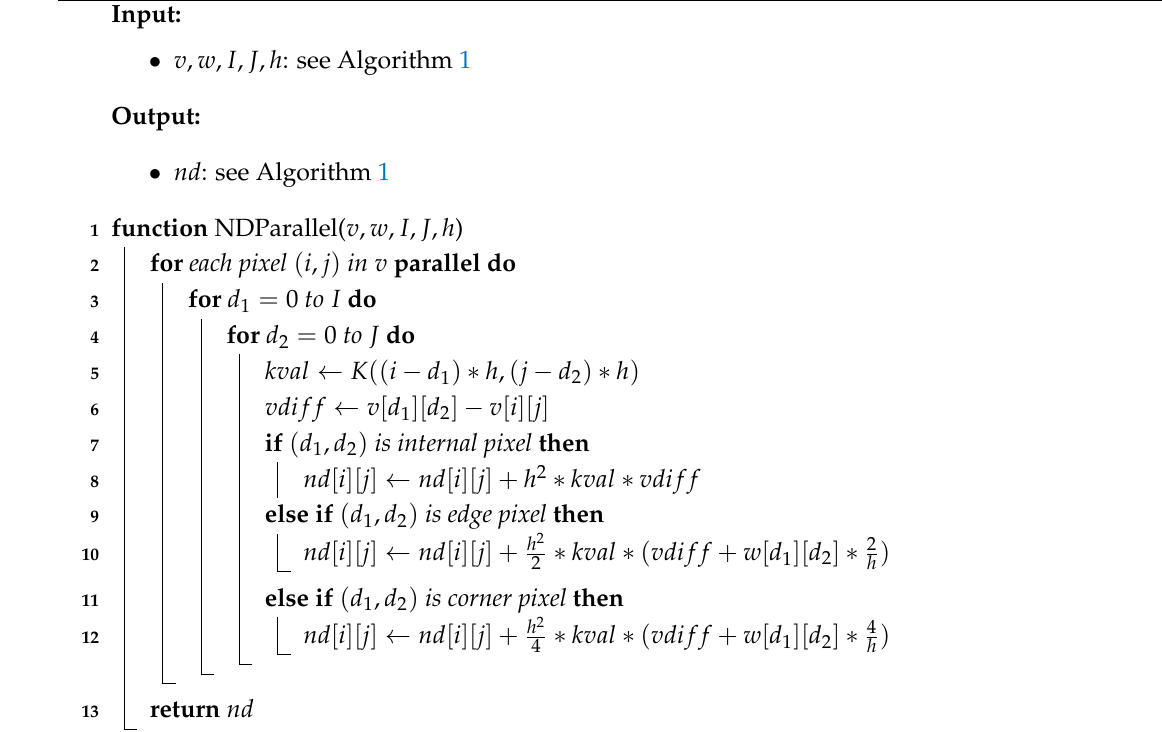
Algorithm 2: Nonlocal diffusion parallel